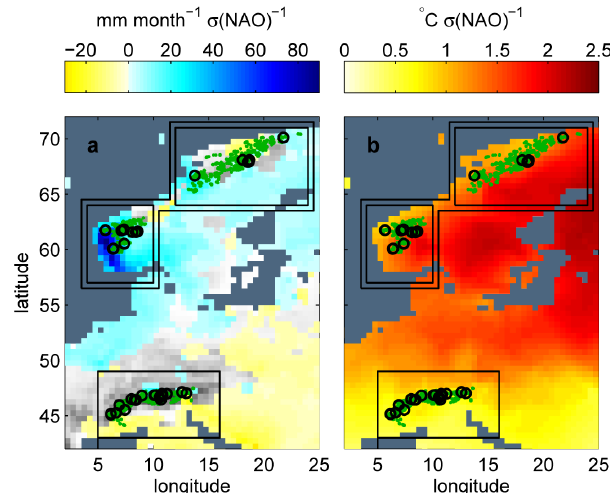
Fig. 1. Maps of regression coefficients of monthly total precipita- tion (a) and monthly mean temperature (b) on the NAO index (shad- ing), values where the correlation between NAO index and precipi- tation/temperature is below the 99% confidence interval have been omitted. Shown are the regression coefficients of the month with the maximum NAO effect, which are generally winter months. Gray background shading: Topography of the CRU TS 3.0 data. Black markers: locations of the glaciers with more than 12 mass balance measurements. Green dots: locations of the glaciers contained in the WGI-XF data base. The boxes indicate the locations of the regions referred to in the text, figures, and